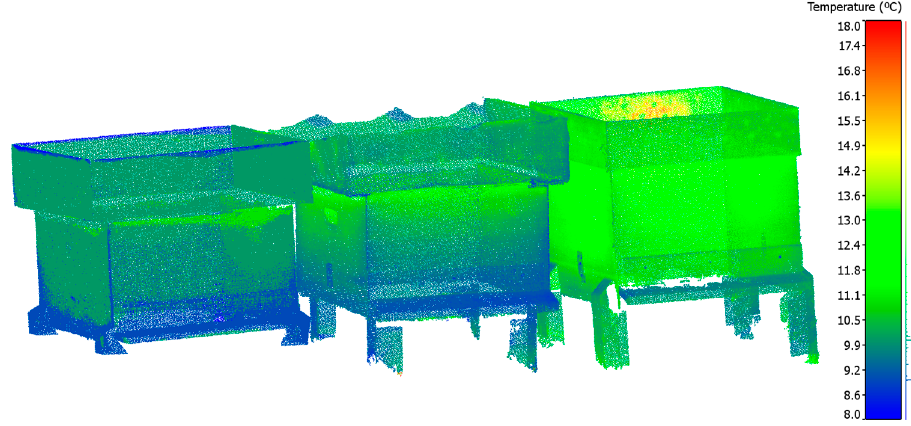
Figure 8. 4D models which integrate metric and thermographic information. Very low level of population ( Left ). Mid level of population ( Middle ). High level of population ( Right ).